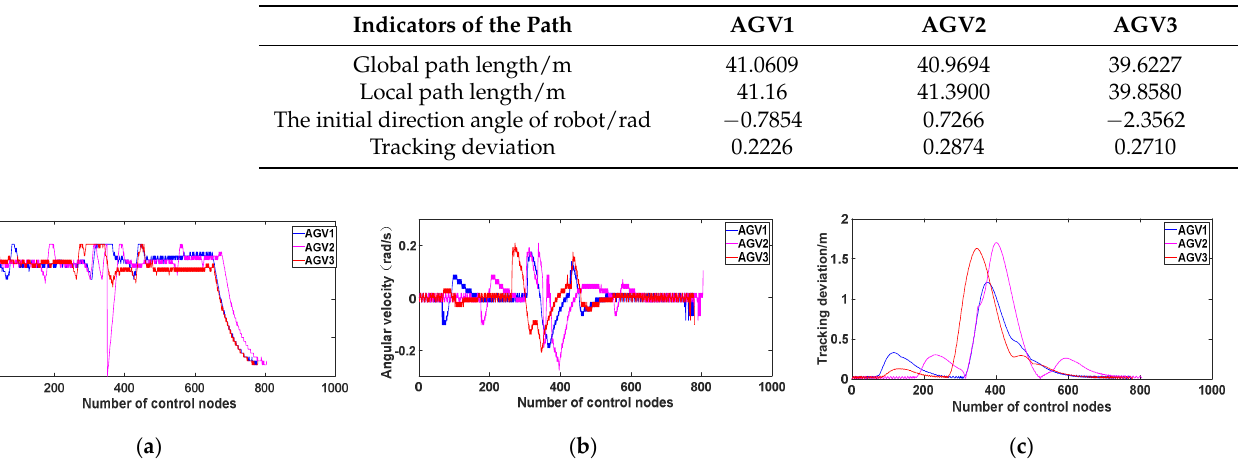
Figure 23. Multi-robot path planning 2. ( a ) Global path planning. ( b ) Robot local motion.